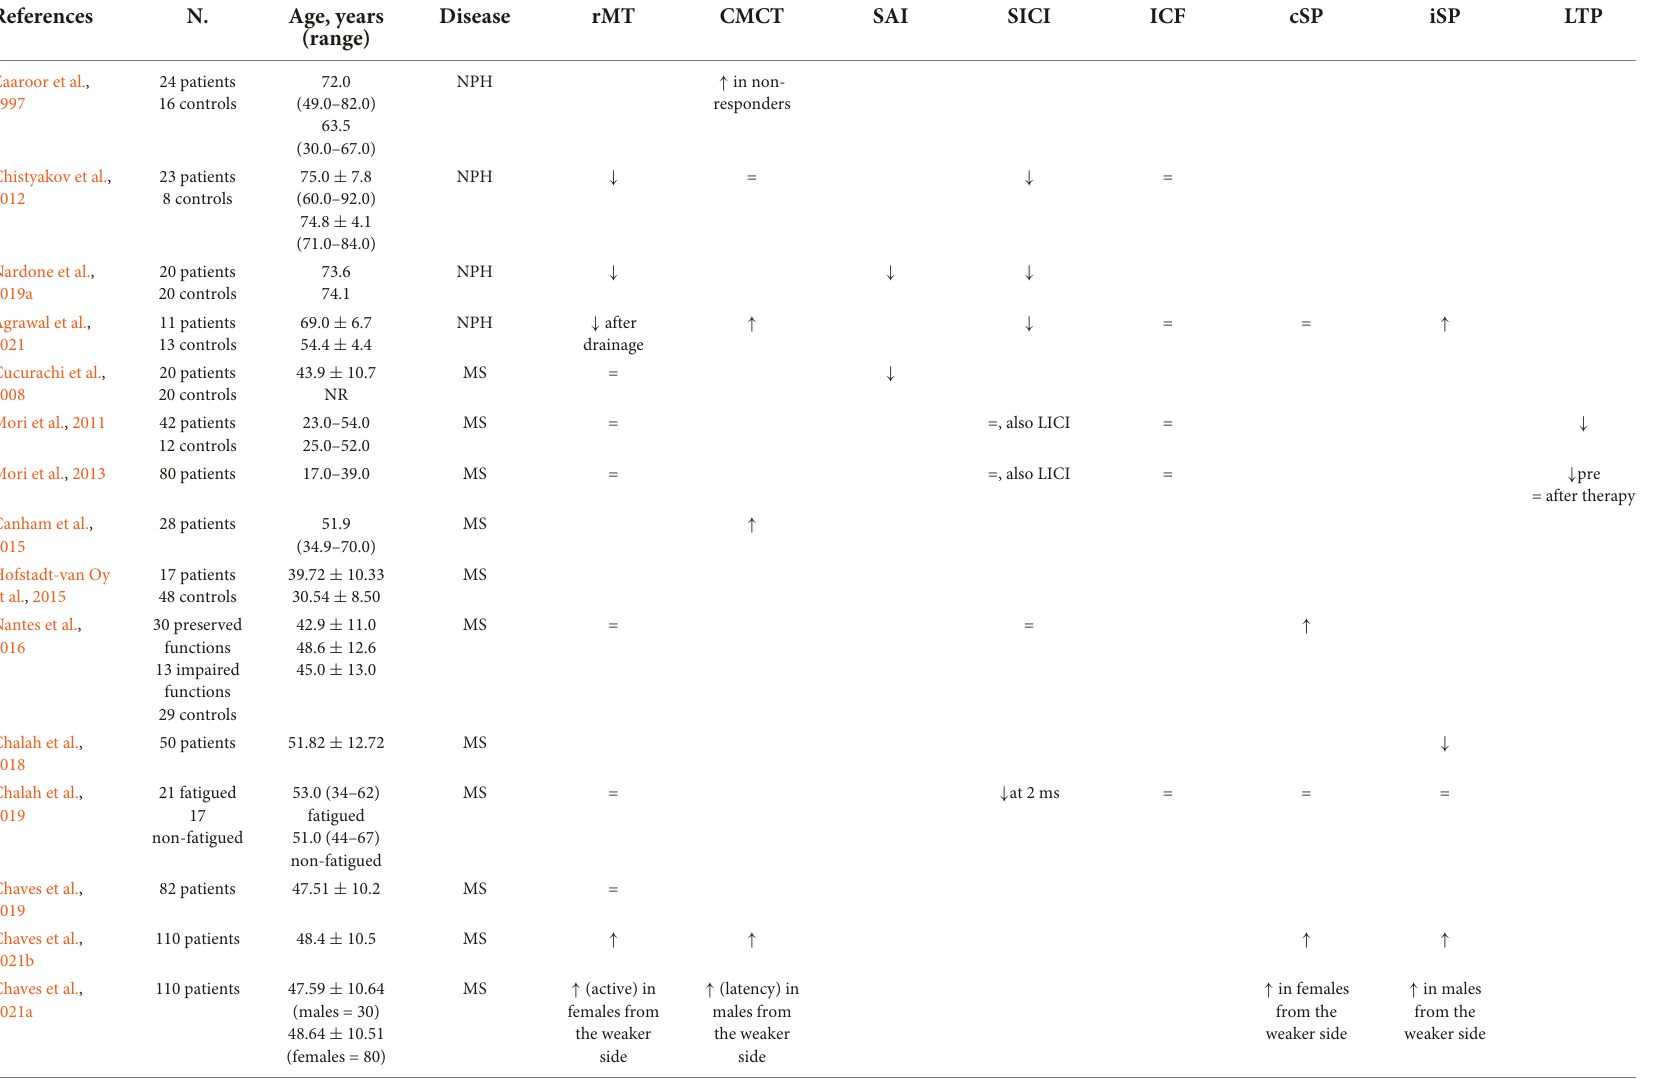
TABLE 1 Relevant transcranial magnetic stimulation (TMS) findings reported in most common secondary cognitive